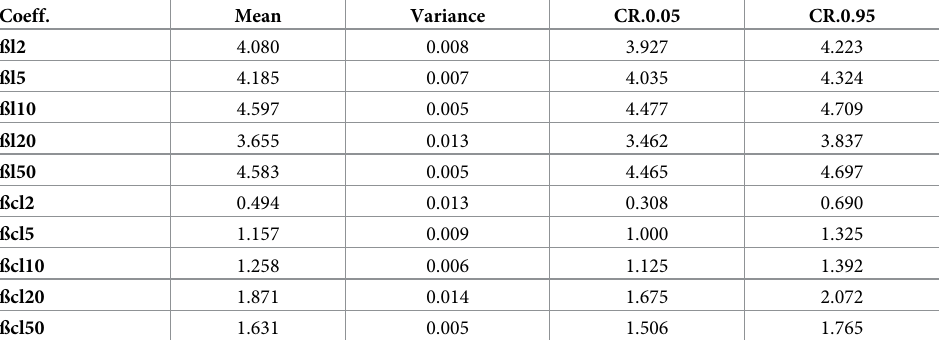
Table 6. β coefficients summary statistics from the posterior distributions (last 10,000 iterations) of number of pheromone lures, and interaction between test and controls and level of pheromones. Coeff.